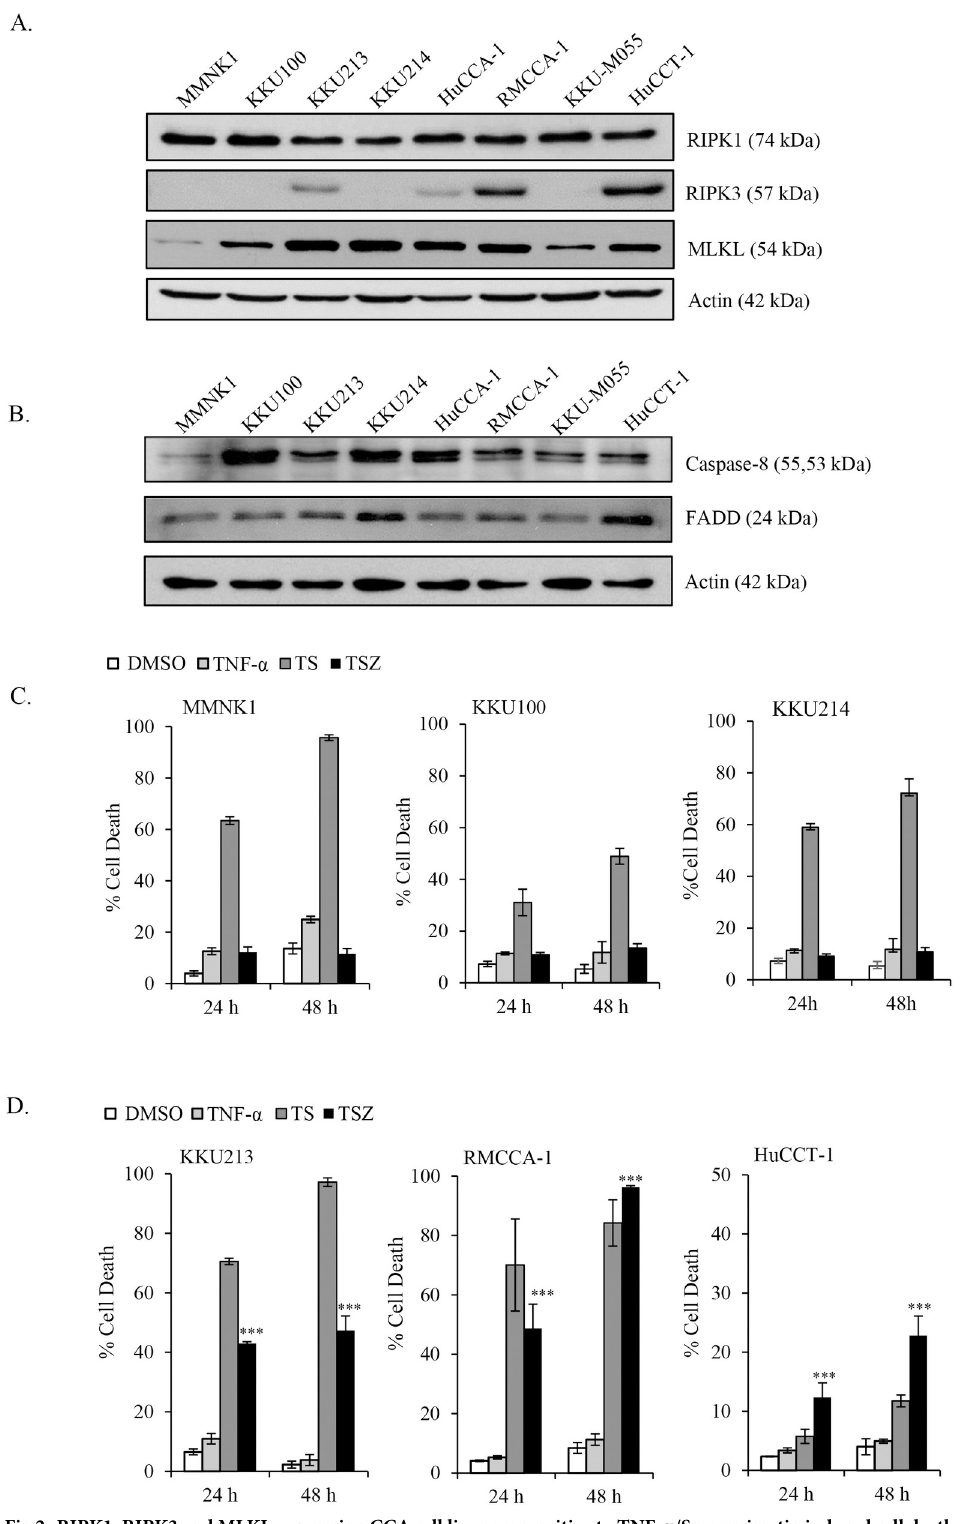
Fig 2. RIPK1, RIPK3 and MLKL-expressing CCA cell lines are sensitive to TNF- α /Smac mimetic-induced cell death upon caspase inhibition. (A) Key necroptotic proteins; RIPK1, RIPK3 and MLKL (B) Protein expression of FADD and caspase-8 were analyzed in 7 different human CCA cell lines and a nontumor human cholangiocyte cell line, MMNK1